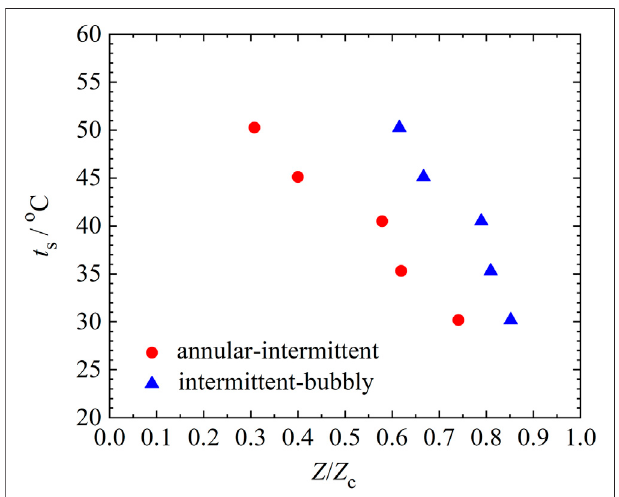
FIGURE 5 | Effect of saturation temperature on fl ow regime transitions. FIGURE 6 | Effect of saturation temperature on relative lengths of the